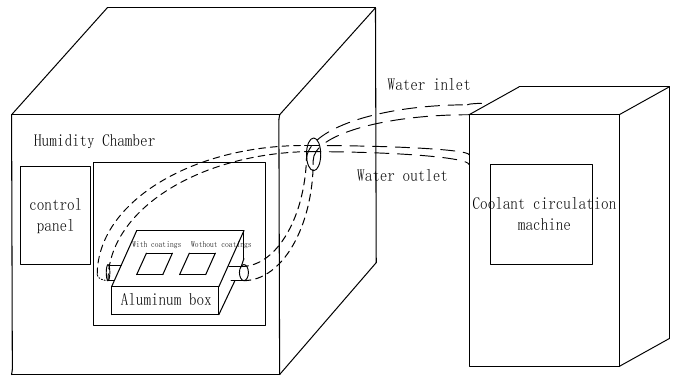
Figure 3. Conceptual diagram of the simulation experiment device.